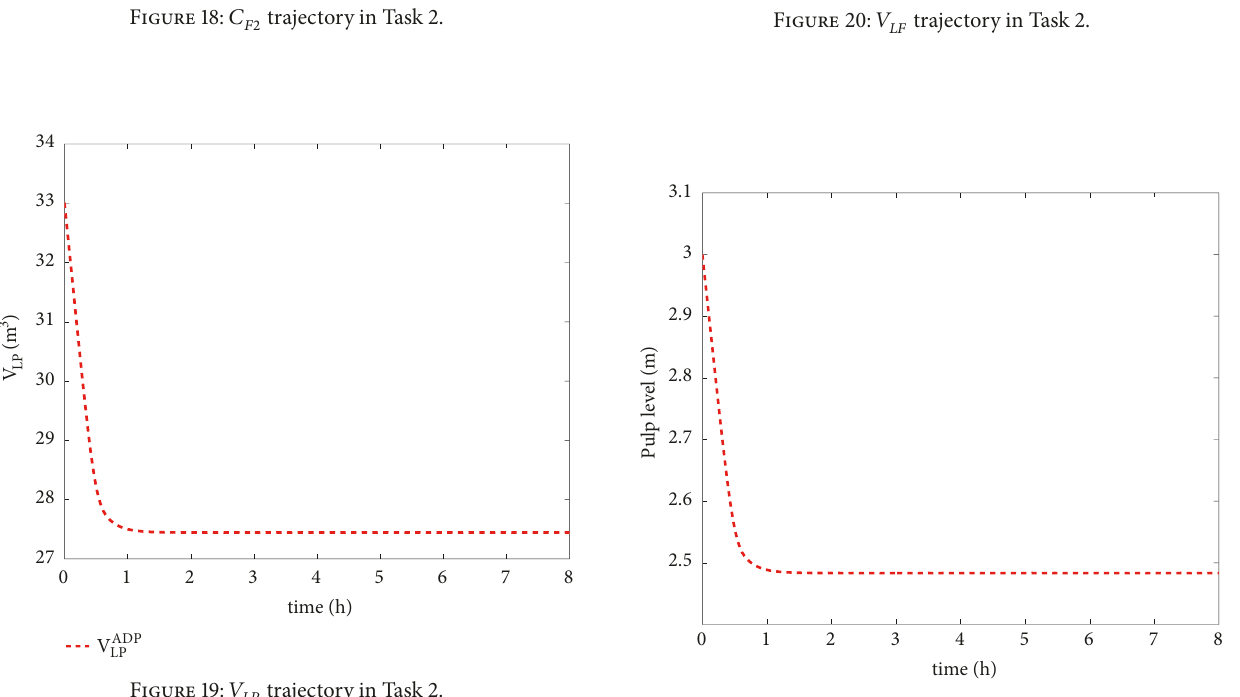
Figure 19: 𝑉 𝐿𝑃 trajectory in Task 2.